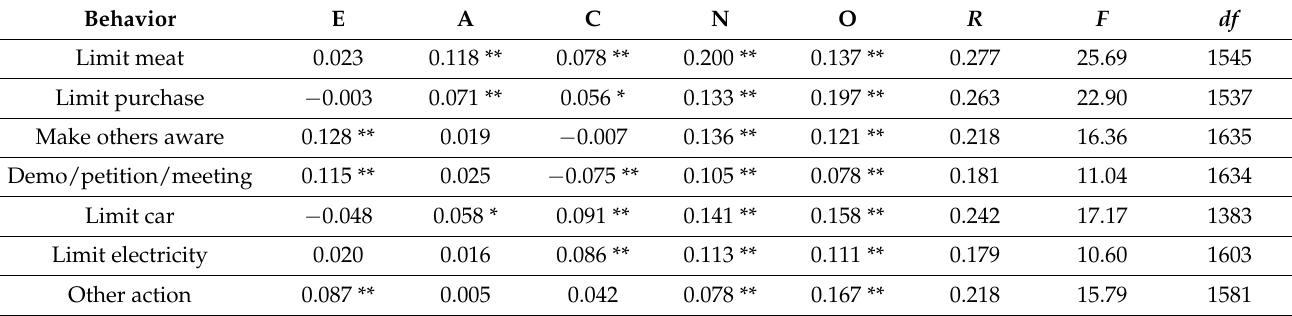
Table 4. Relationships between personality and climate change mitigation behavior: Study